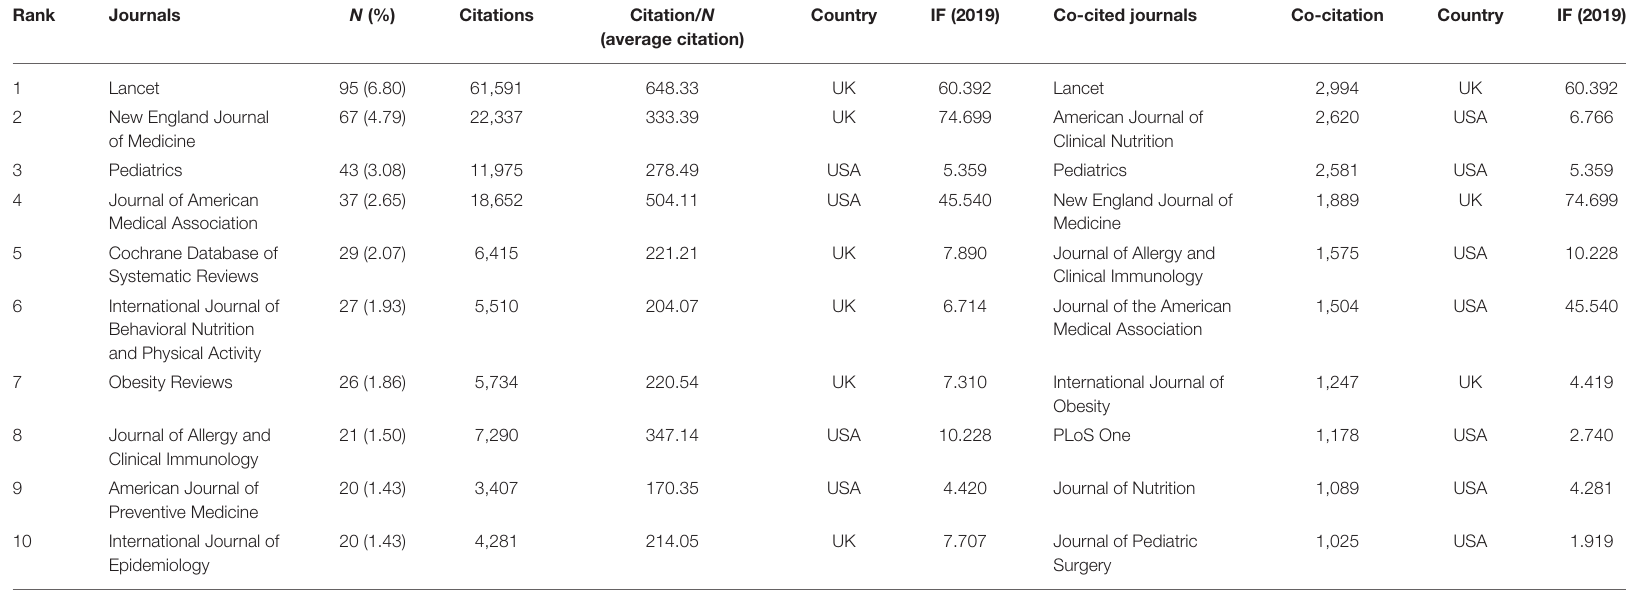
TABLE 3 | The top 10 journals and co-cited journals [ n